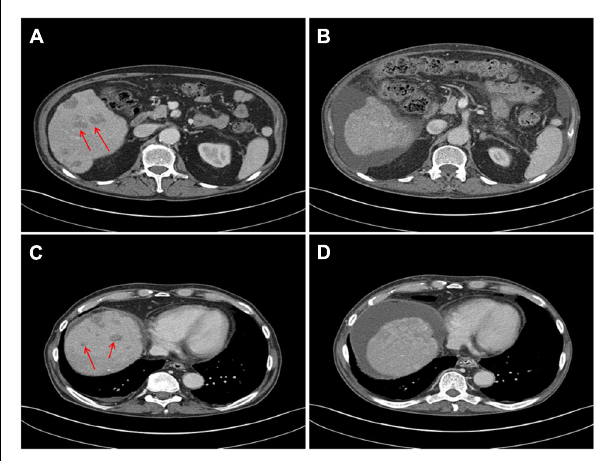
FIGURE 2 | CT scans before (A,C) and 5 weeks after initiation of treatment with pemetrexed (B,D) show decrease in size of metastases and liver sclerosis and ascites due to previous